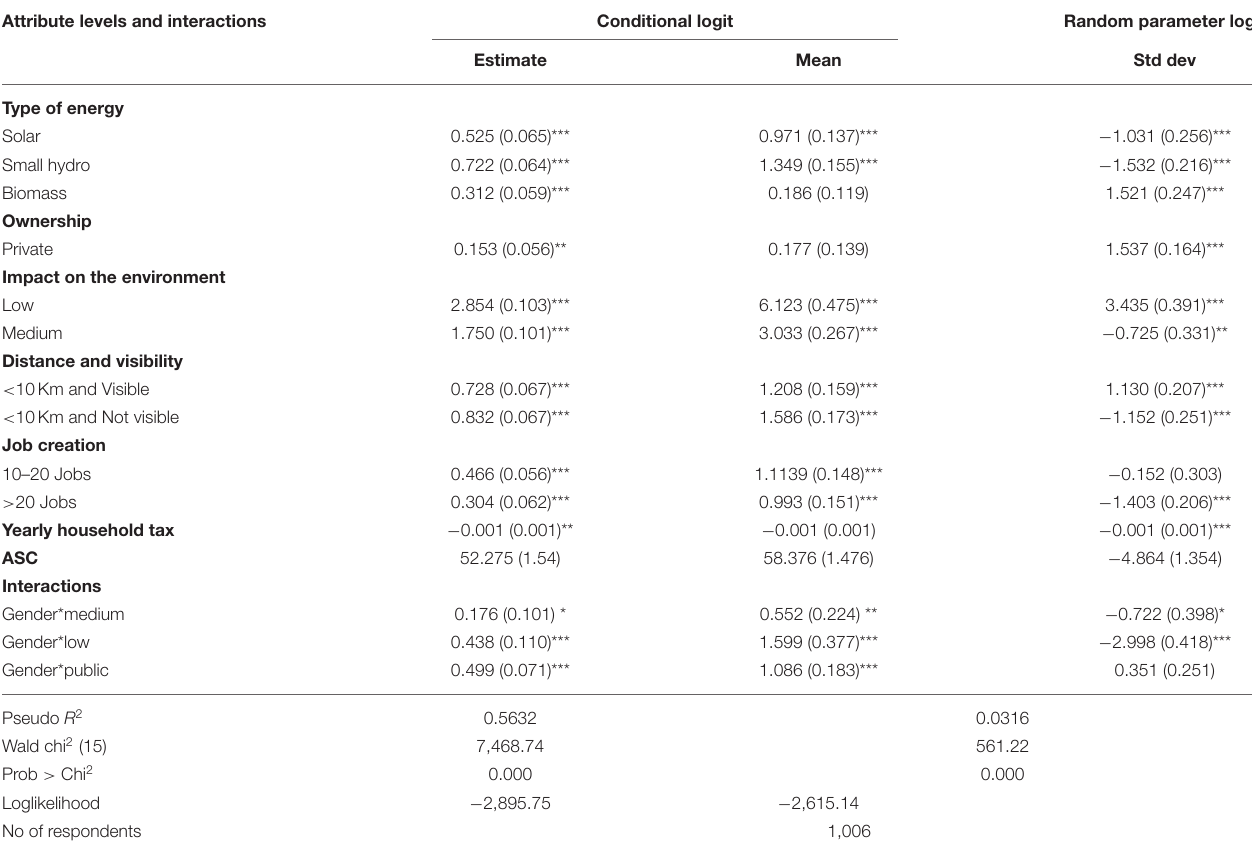
TABLE 5 | Parameter estimates standard errors within parenthesis. Attribute levels and